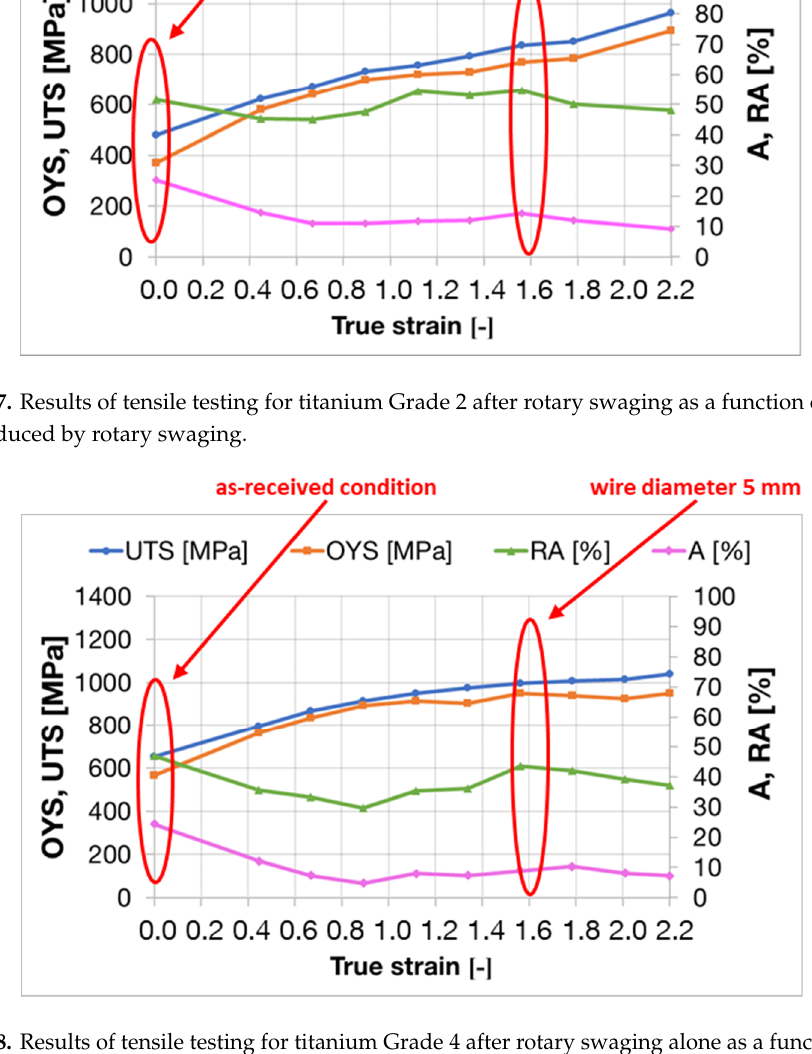
Figure 18. Results of tensile testing for titanium Grade 4 after rotary swaging alone as a function of the true strain induced by rotary swaging.